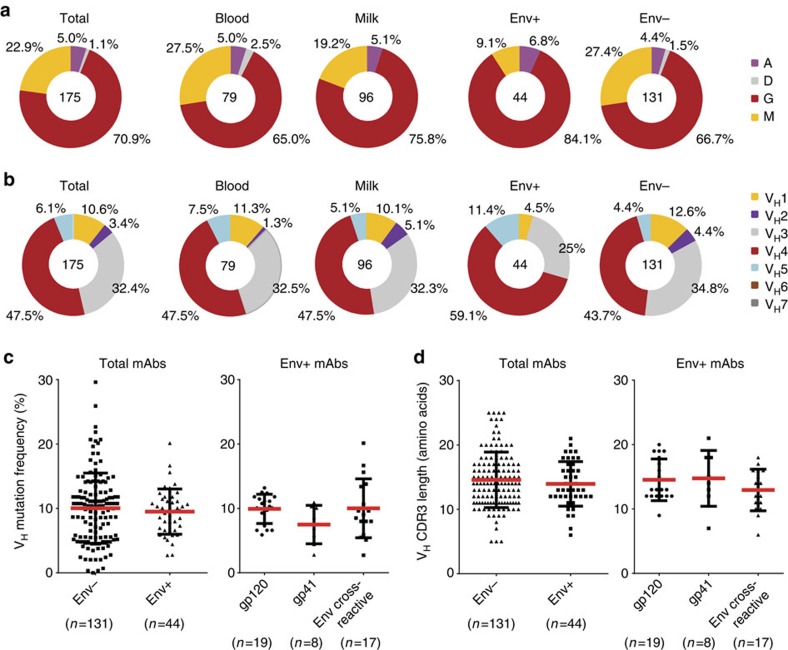
Genetic characterization of monoclonal antibodies (mAbs) isolated from single-cell sorted memory B cells of chronically SIV-infected AGMs.Isotypes and VH families determined by alignment with human germ lines are shown in pie charts. Numbers of antibodies were indicated at the centre of each pie chart. Percentage of each isotype or individual VH gene families of the isolated antibodies isolated from milk and blood including Env-reactive and non-Env-reactive antibodies are indicated. (a) IgG isotype was dominant both in blood (65%) and milk (75.8%) memory B cells, and over-represented in Env-specific memory B cells (84.1%). (b) VH4 and VH3 were dominant VH families and used AGM in both Env-specific and non-Env-specific mAbs. (c) VH mutation frequency of Env-specific, non-Env-specific and Env epitope-specific AGM mAbs. (d) HCDR3 length of Env-specific, non-Env-specific and Env epitope-specific AGM mAbs. There was no difference in VH mutation frequency and HCDR3 length among Env-specific and non-Env-specific, or Env epitope-specific AGM mAbs. SHM frequency comparisons were made by an exact Wilcoxon rank sum test and HCDR3 lengths were made by a Kolmogorov–Smirnov test.